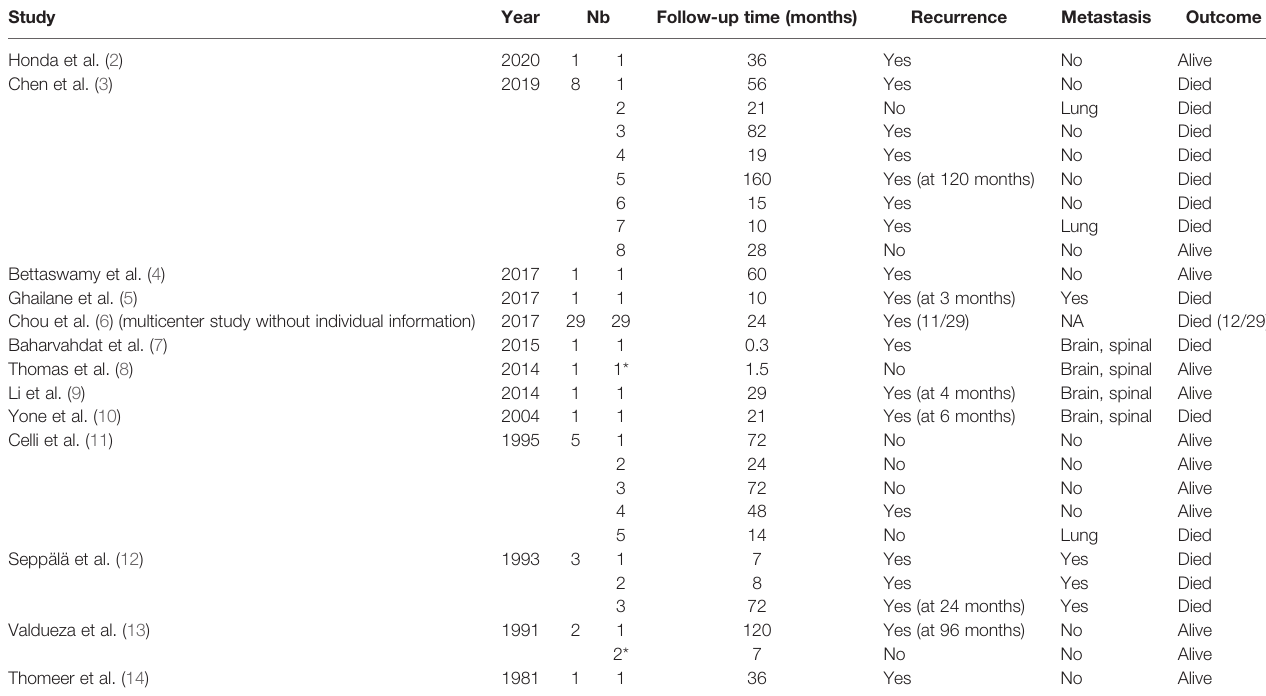
TABLE 3 | The follow-up and prognosis of these patients.